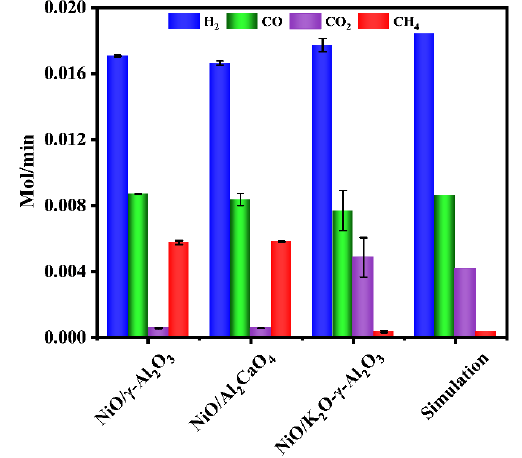
Figure 2. Comparison of autothermal reforming performance over different Ni-based catalysts (reaction condition: temperature = 700 °C, the flow rate of toluene = 0.2 mL/min, the flow rate of water = 0.31 mL/min, the flow rate of dry air = 317.4 mL/min).